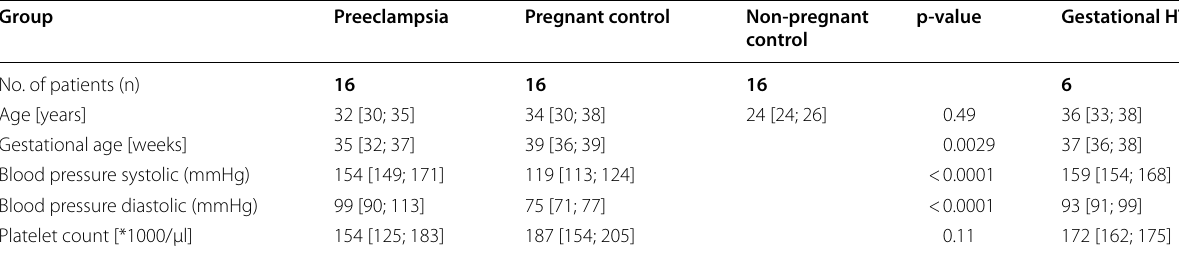
Table 1 Patient baseline characteristics Group